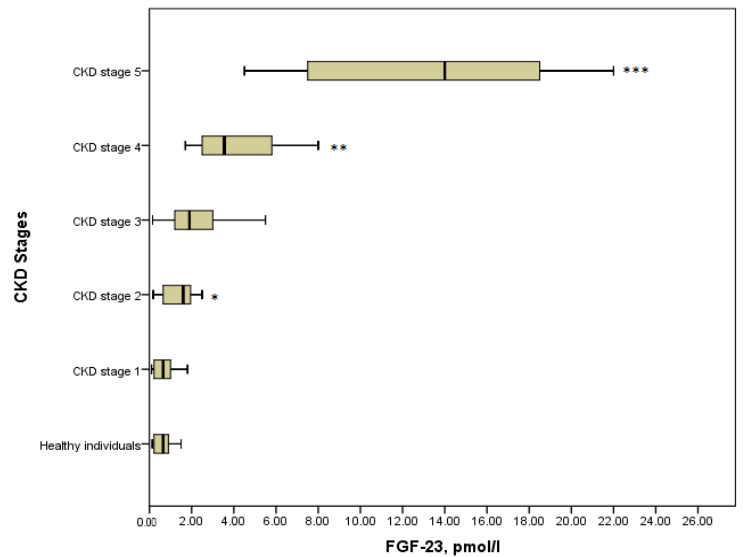
Figure 1. FGF-23 concentration in the various CKD stages ( p = 0.000). * p = 0.029 CKD stage 2 vs. CKD stage 1; ** p = 0.021 CKD stage 4 vs. CKD stage 3; *** p = 0.001 CKD stage 5 vs. CKD stage 4.